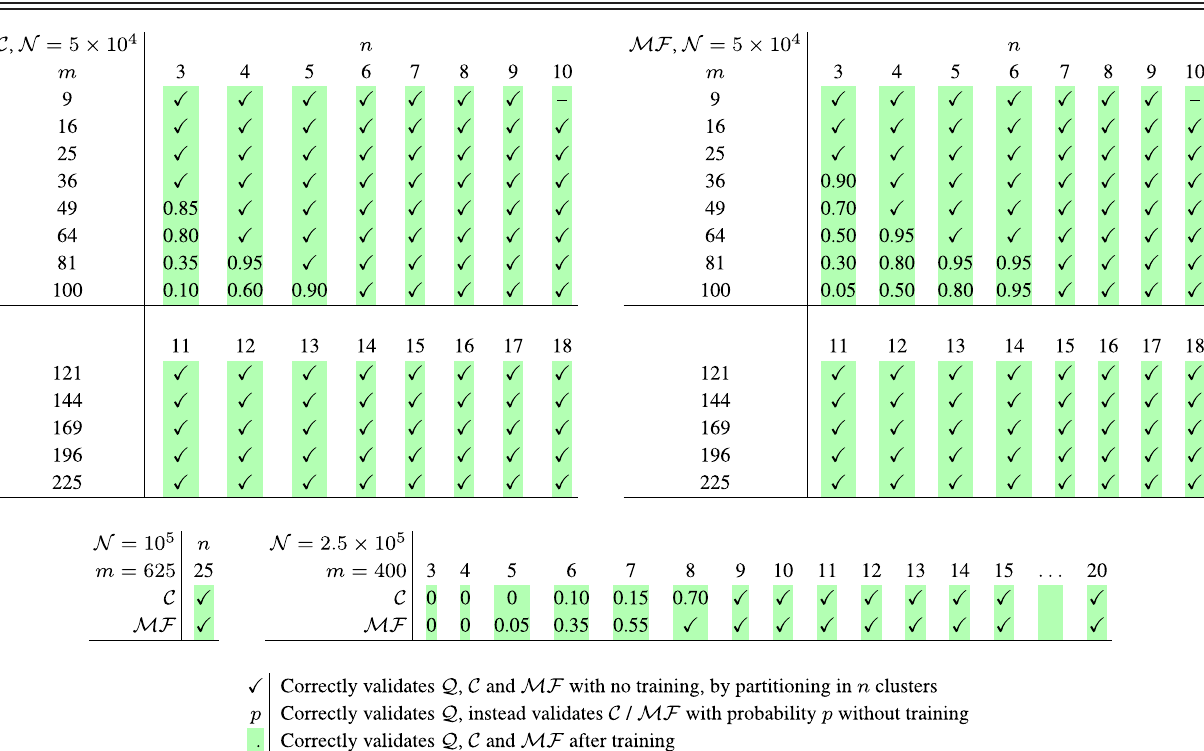
TABLE IV. Efficacy of K means++ for large-size boson sampling [cross-validation stage, step (ii.b)]. The algorithm is highly effective to discern quantum ( Q ) boson samplers from classical ( C ) and mean-field states ( MF ), even for a large number of photons n and modes m and using very small sample sizes ( N ) as compared to the number of output combinations. For all probed ( n , m ), K means correctly identifies the nature of the Q sample, while, when tested with adversarial samples, it still correctly identifies all their instances after proper training. K means is initialized by K means++, with optimized hyperparameters and majority voting. Numerical samples of bona fide boson samplers are generated using the algorithm by Clifford and Clifford